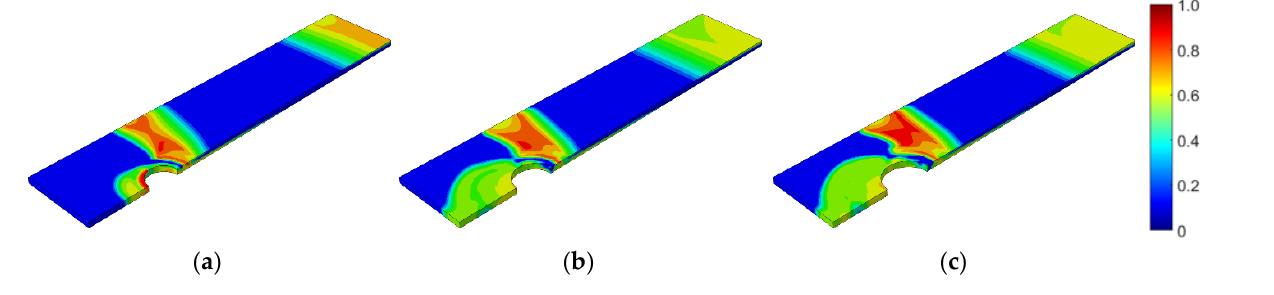
Figure 9. Fatigue distribution of the normalized logarithmic life repeats in the upper plate for the model with a prestressed bolt with a nut diameter of: ( a ) 10 mm; ( b ) 12 mm; ( c ) 14 mm.